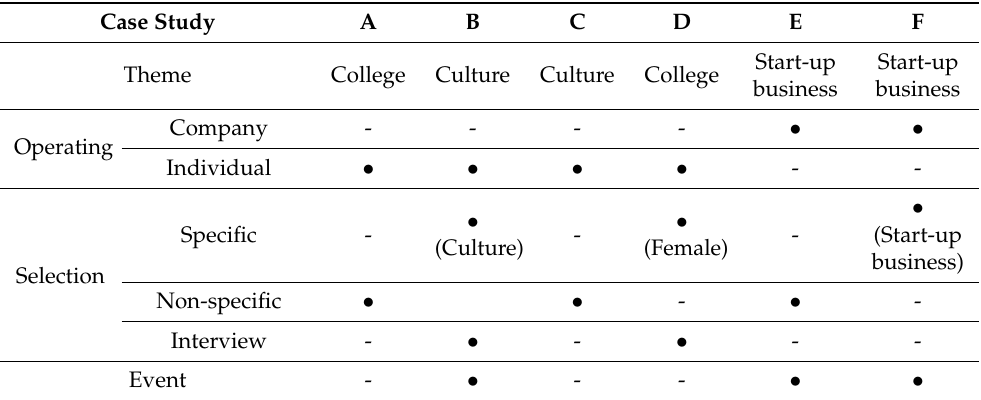
Table 11. Components of operating method in each case study (yes • , no